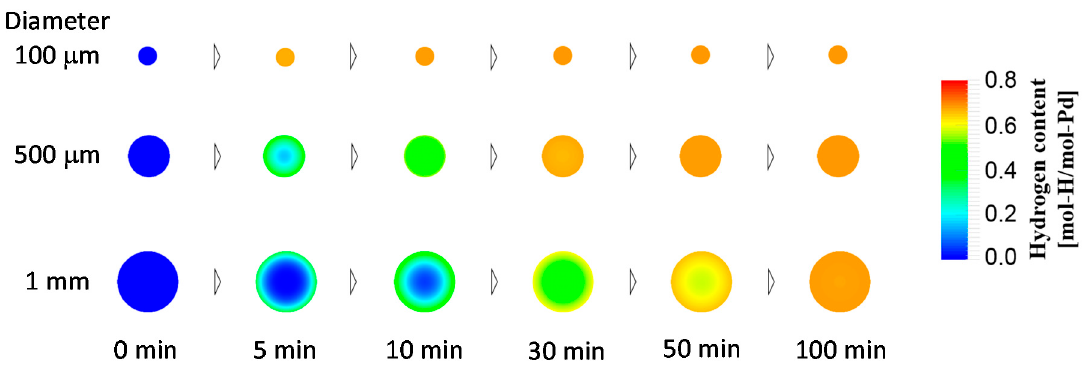
Figure 8. Spatial hydrogen concentration profiles in spherical Pd particles at 5, 10, 30, 50, and 100 min after the beginning of hydrogen absorption process for Pd particles of different diameters.